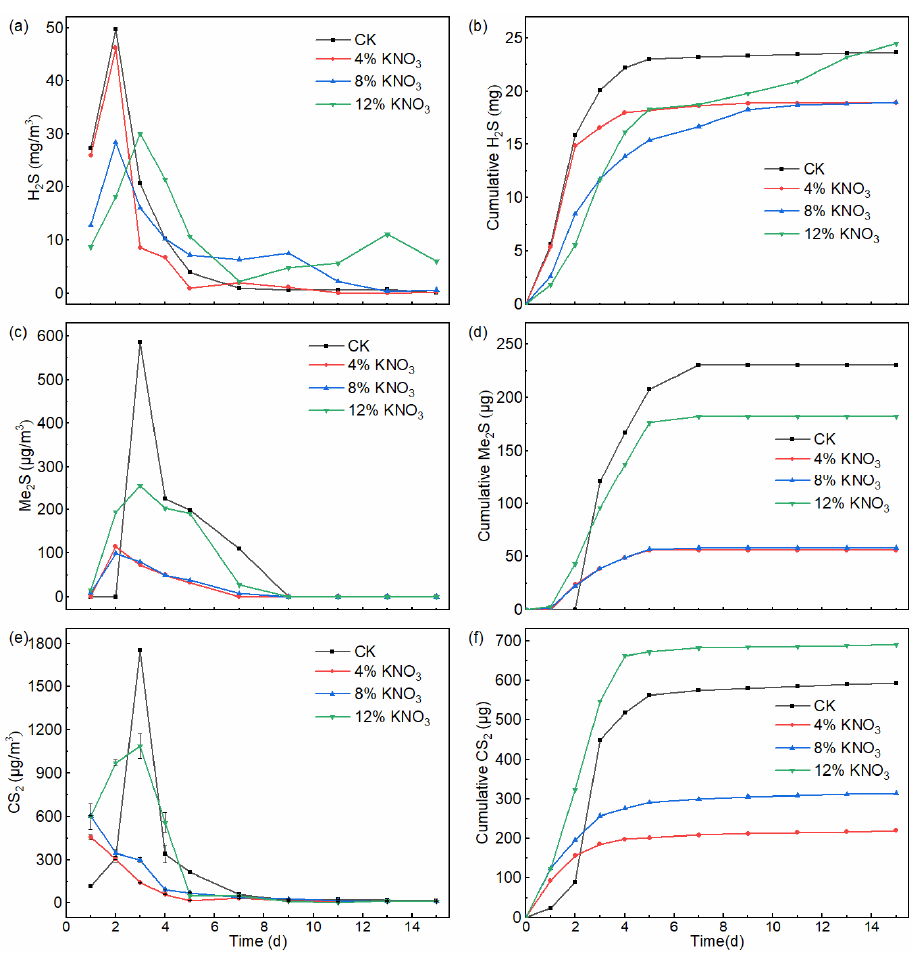
Figure 3. The dynamics of H 2 S ( a ), DMS ( b ), and CS 2 ( c ) emissions and the cumulative emission of H 2 S ( d ), DMS ( e ), and CS 2 ( f ) from the composting pile under different KNO 3 additions.